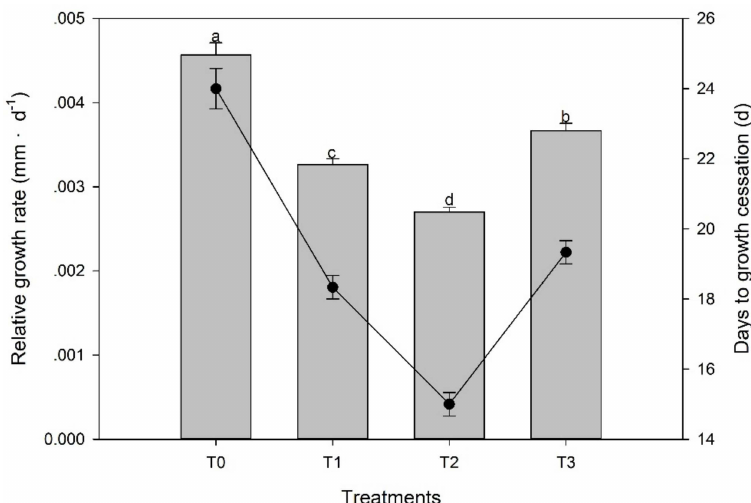
Figure 3. Relative growth rate (RGR) in the shoots of Magnolia wufengensis under ethephon (ETH) treatments is shown in the bar chart. Days to growth cessation in the shoots of Magnolia wufengensis under ETH treatments is shown in the line graph. T0, T1, T2, and T3 indicate the ETH application of 0, 700, 1000, and 1500 mg · L − 1 , respectively. Di ff erent letters indicate significant di ff erences ( p < 0.05) among treatments. Data are presented as the means ± SDs ( n = 10). The same is shown below.